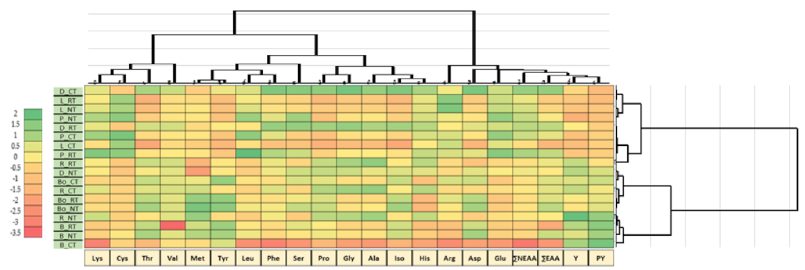
Figure 2. Relationship between amino acids, seed yield and protein yield. Normalized values were scaled (+2 > − 3.5). D—‘Dalbor’; L—‘Lord’; P—‘Perkoz’; R—‘Regent’; Bo—‘Boros’;